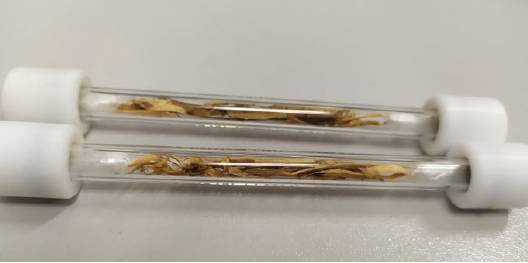
Figure 4. Chips planed from wooden floor staves coated with bituminous products, ready for ther- mal desorption tests. desorption